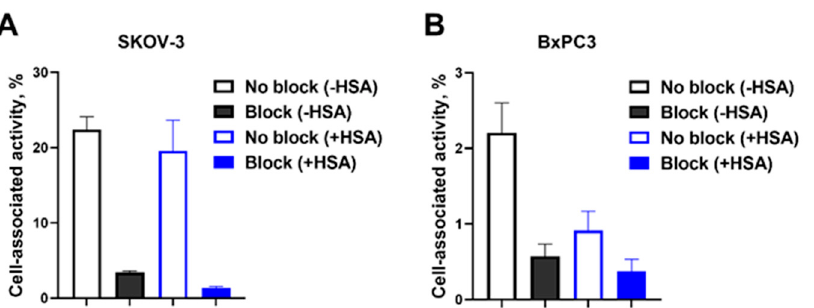
Figure 4. In vitro specificity of [ 177 Lu]Lu-PEP40233 binding to ( A ) SKOV-3 and ( B ) BxPC3 cells in the presence and absence of HSA. Block refers to pre-saturation of HER2 receptors with unlabeled PEP40233. The data are presented as an average value from 3 samples ± SD. The data demonstrate specific binding to both cell lines, and both in the presence and absence of HSA.